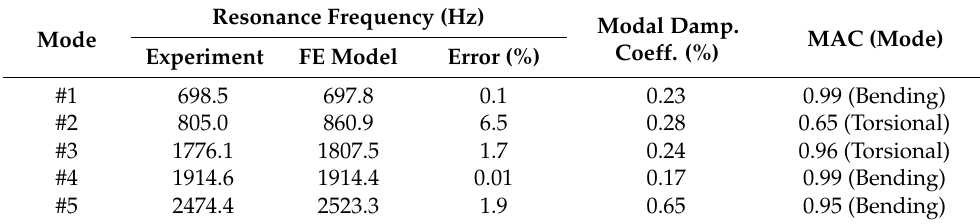
Table 1. Correlation of the modal parameters for the SS275